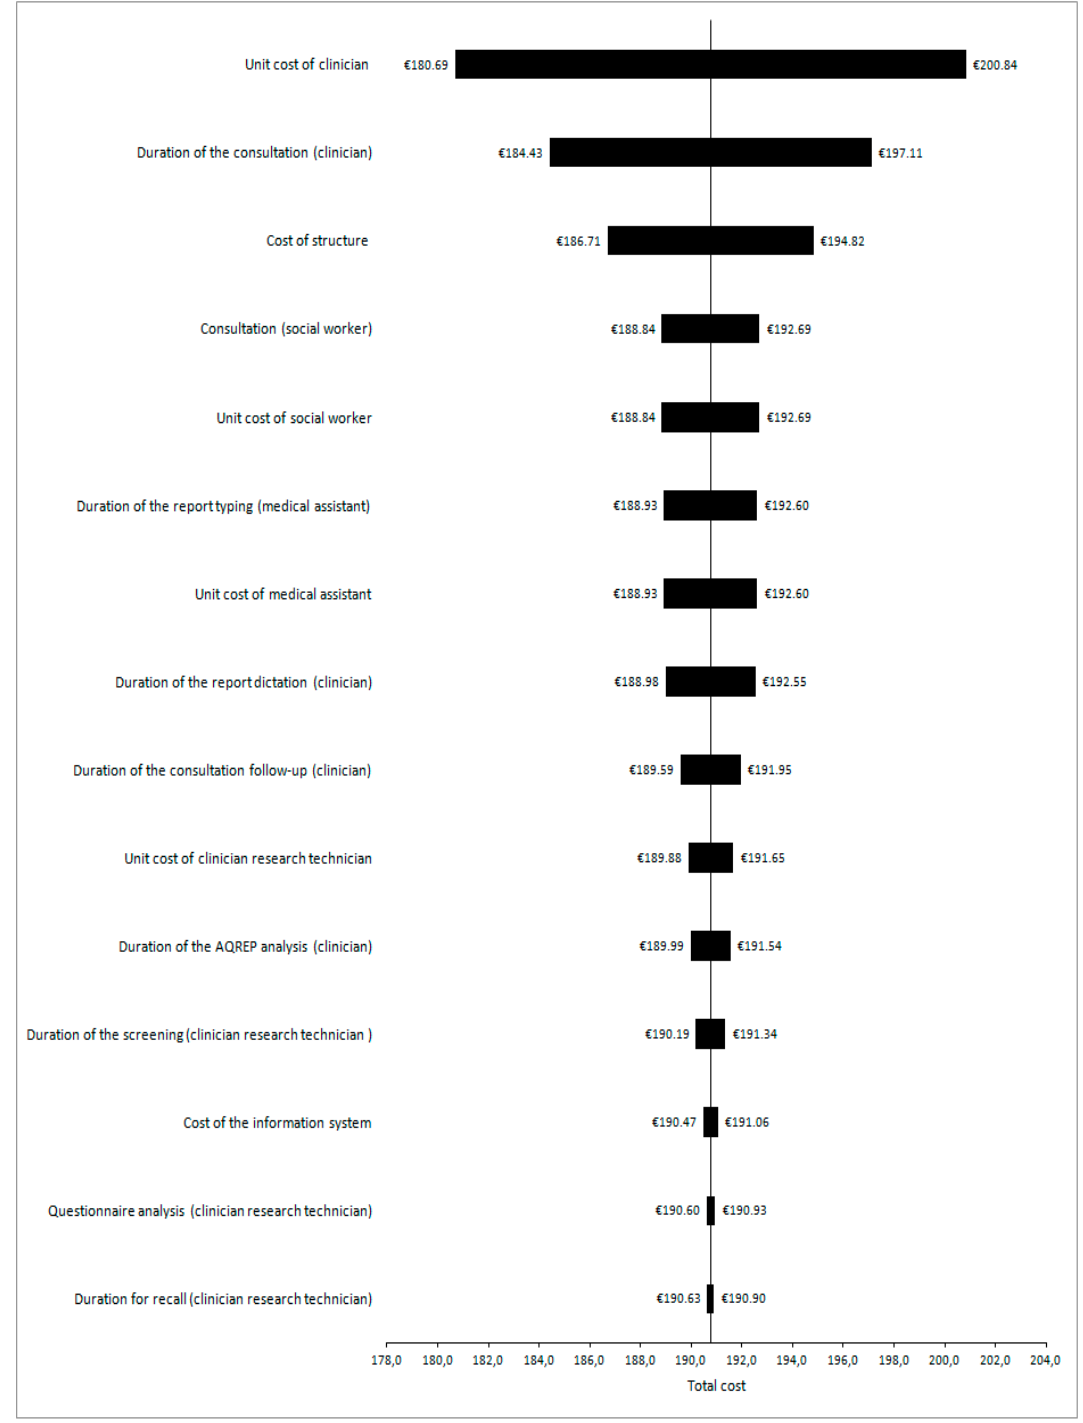
Figure 2. Tornado diagram for Situation 1 (Self-administered questionnaire (SAQ) returned by the patient and consultation required based on the information provided by the patient in the